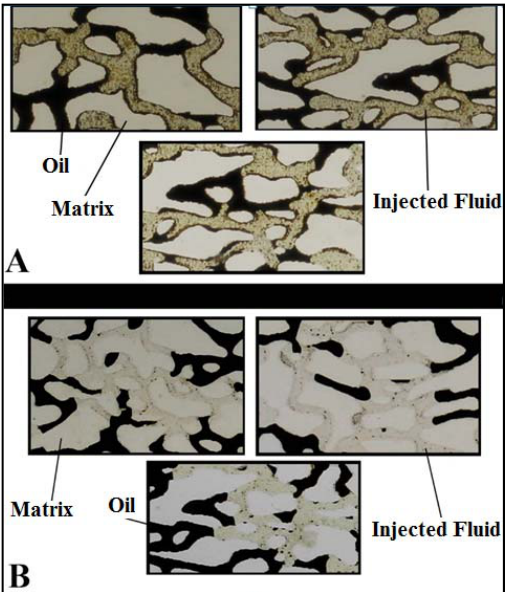
Fig. 13. Pore scale photos of different parts of micromodel glass: A) Ethanol injection and B) Ethanol-silica injection